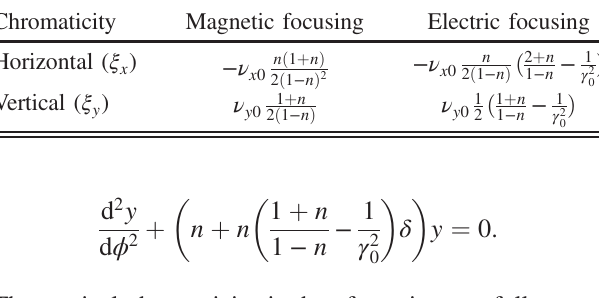
TABLE I. Analytical approximations of the transverse chro- maticities in the magnetic and electric weak focusing storage rings. Chromaticity Magnetic focusing Electric